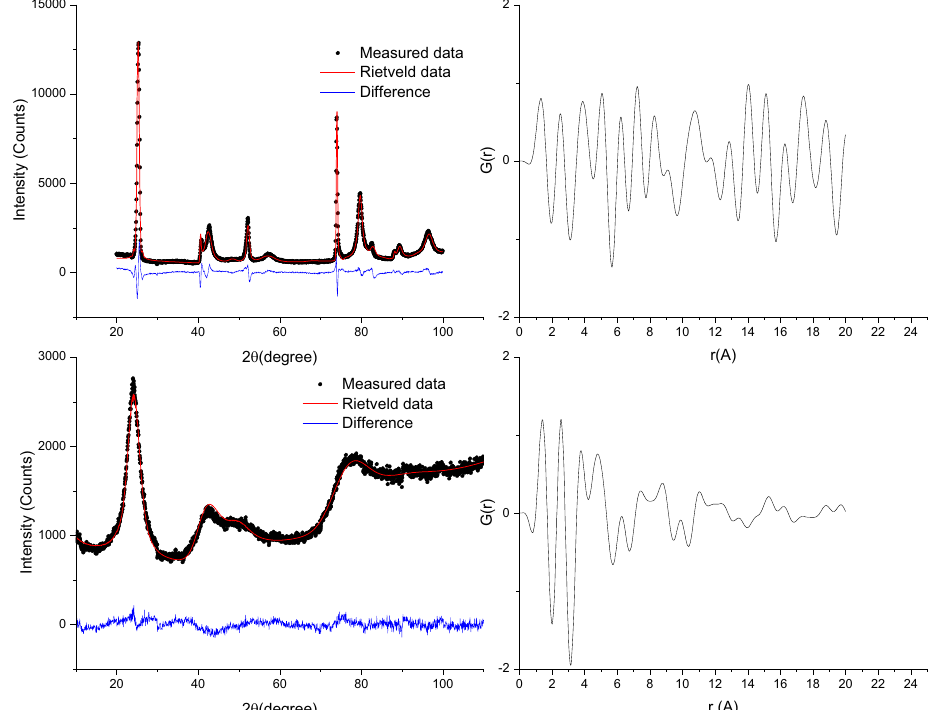
Fig. 7. Neutron powder diffraction patterns and PDF of nuclear graphite samples. The top plots represent unirradiated samples. The bottom plots are for irradiated samples showing the loss of the planar graphite structure.